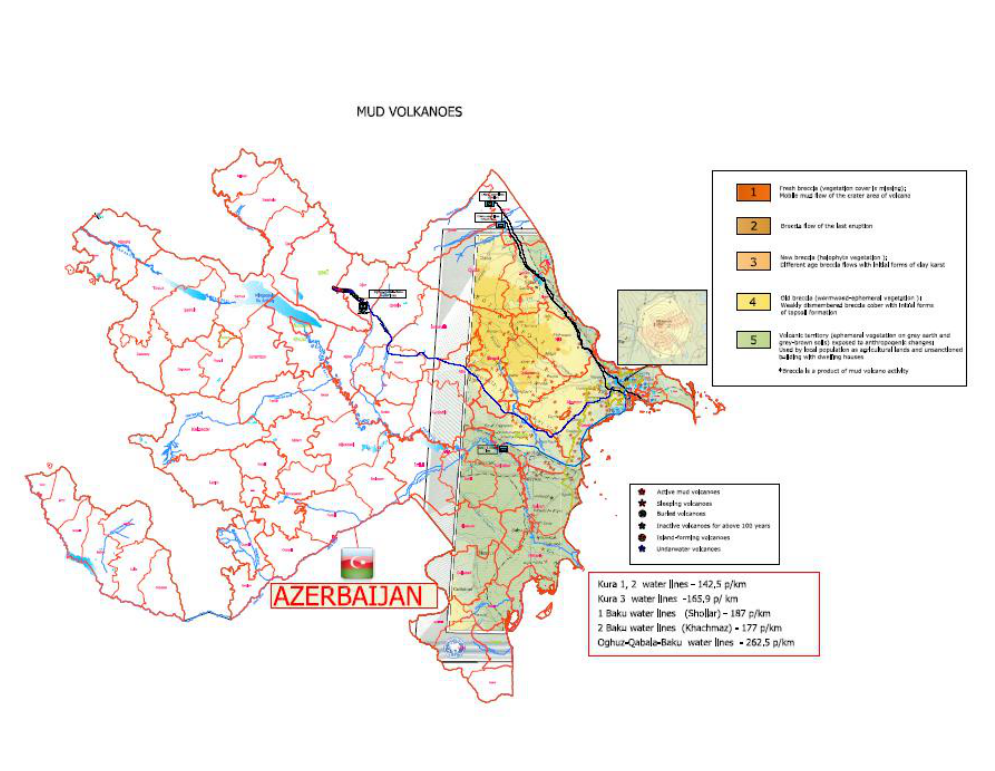
Figure 3. Mud volkanoes in